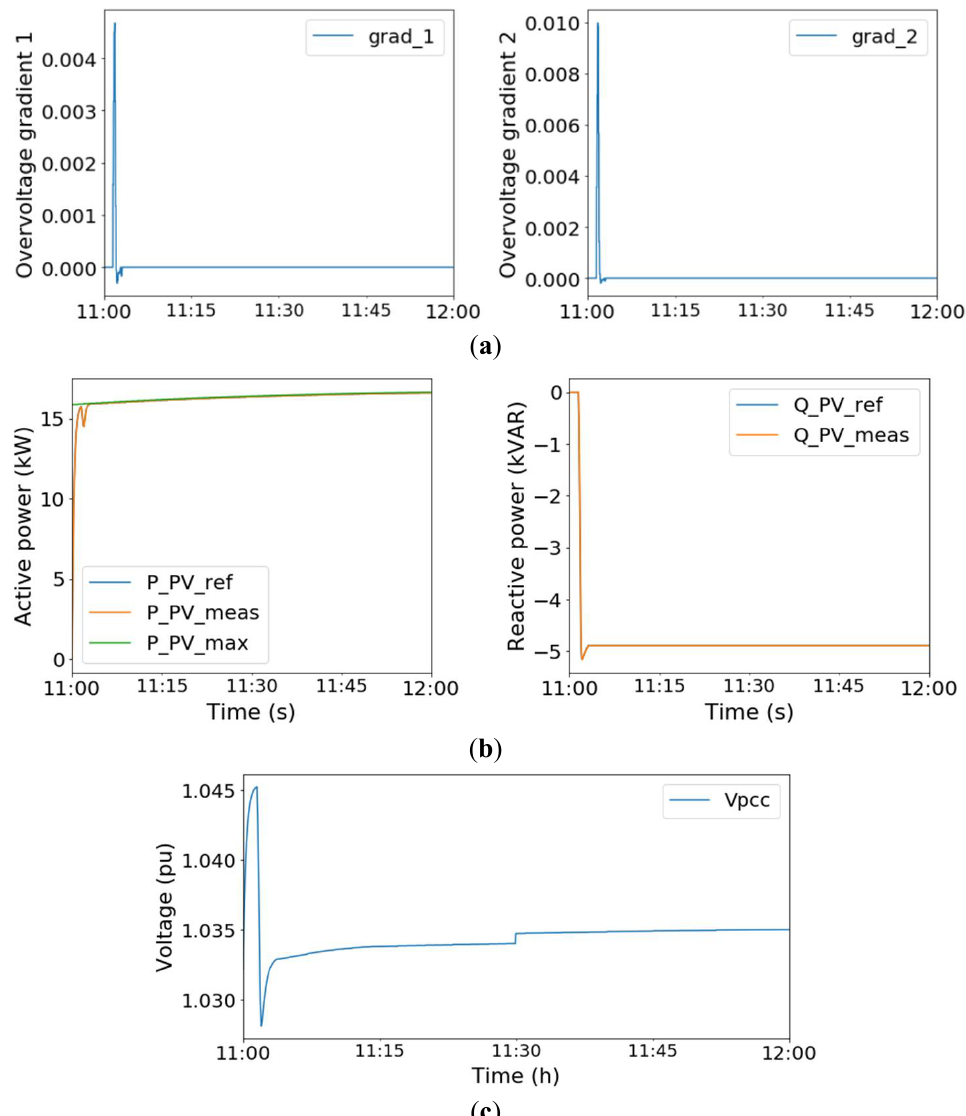
Figure 19. Results of a selected simulated local controller of PV: ( a ) the dual variables received from the Heila coordinator; ( b ) the optimal power set points and measurements of PV and ( c ) the PCC voltage of PV.